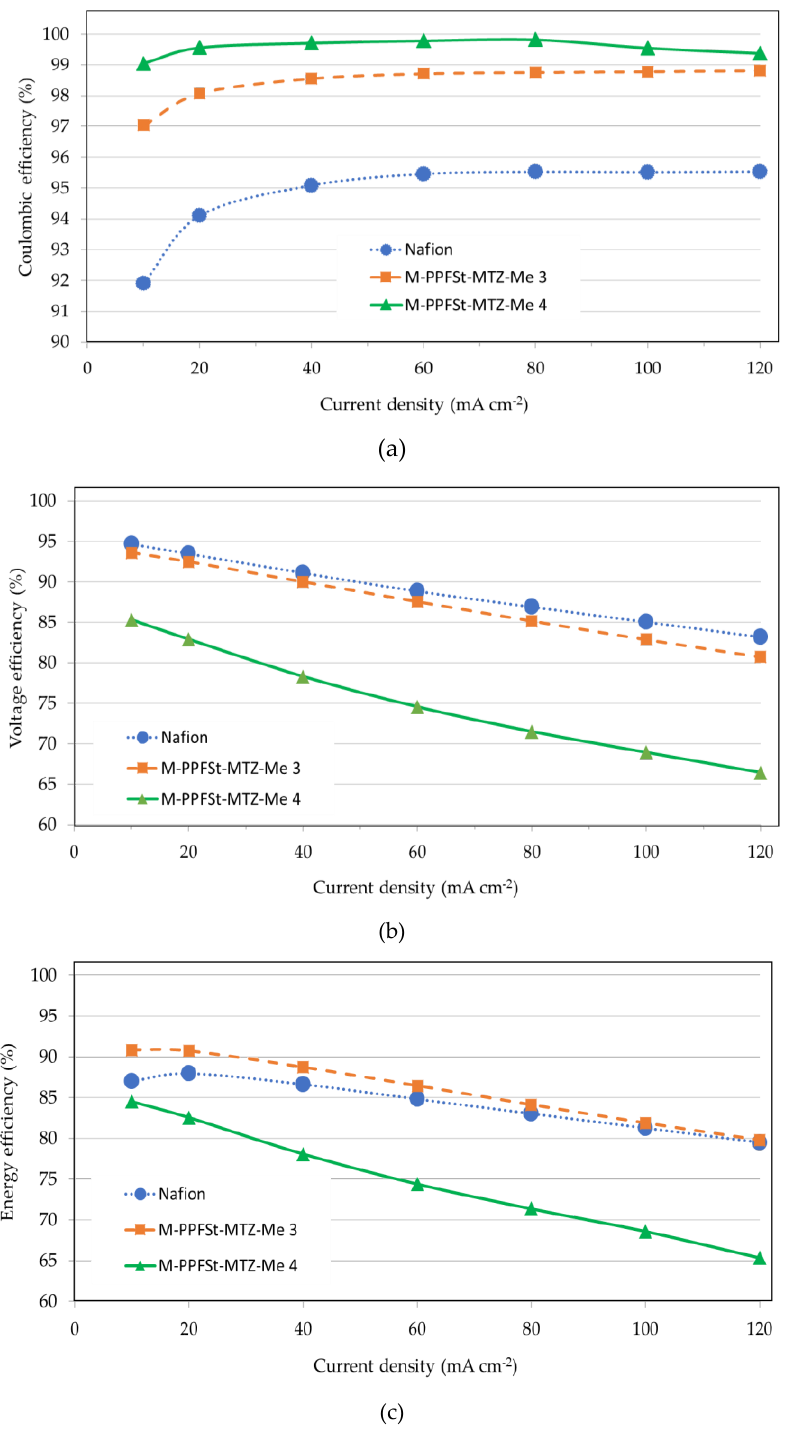
Figure 6. The coulombic efficiency ( a ), voltage efficiency ( b ) and energy efficiency ( c ) of Vanadium Redox Flow Batteries (VRFBs) as a function of the current density.